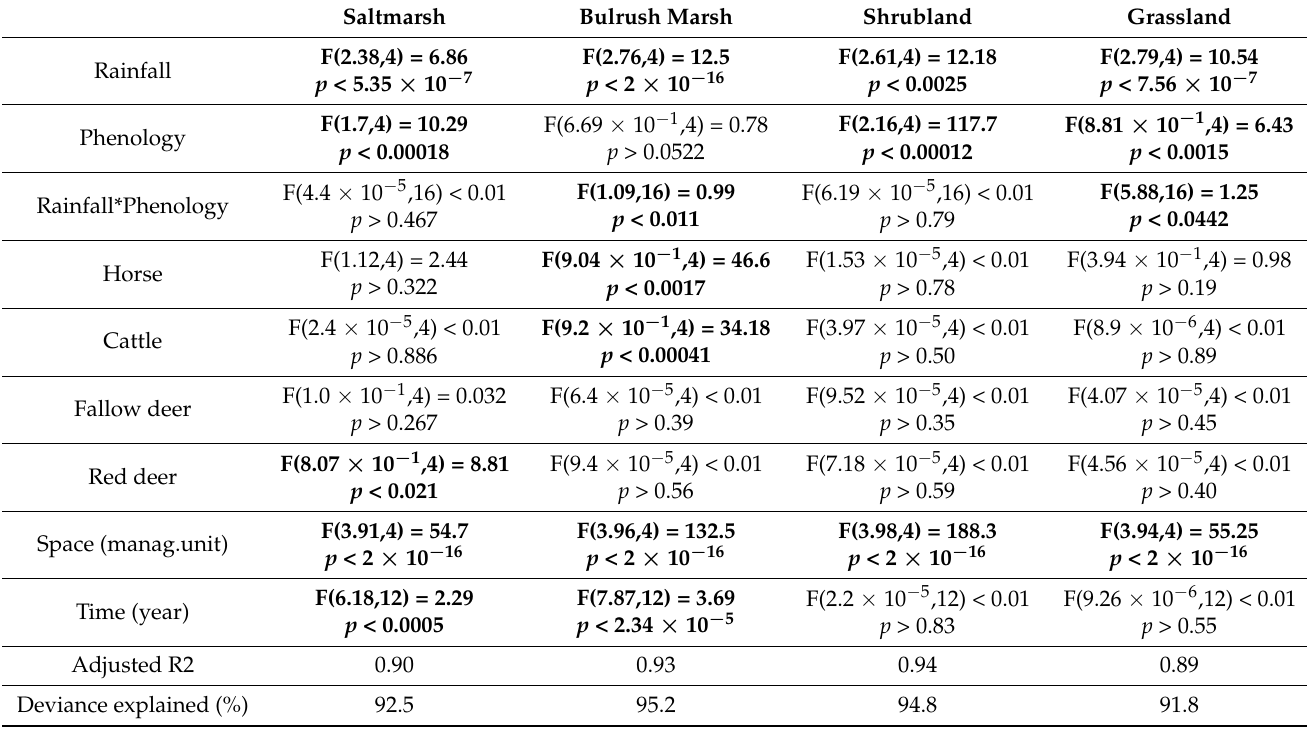
Table A1. Significance tests and probability levels of the alternative gam models, using the beginning-of-the-season values of ungulate census, predicting plant production (peak NDVI) fitted separately for each vegetation type. Only the predictor variables included in the “best” model are